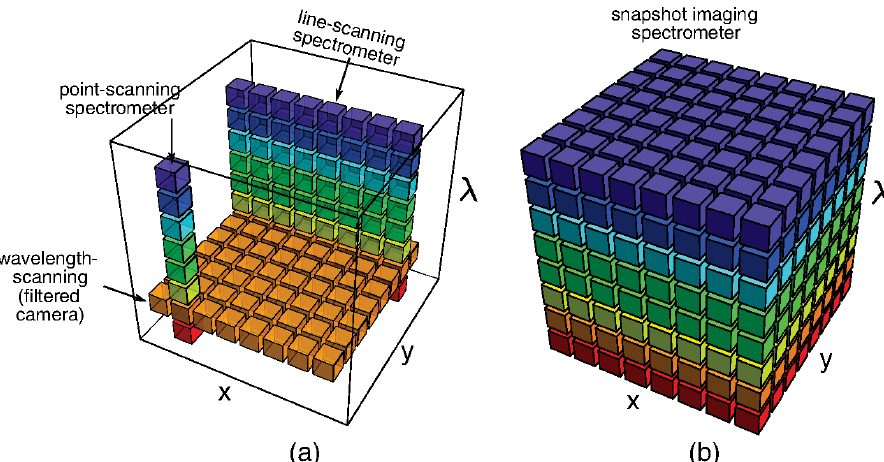
Figure 7. The portions of the datacube collected during a single detector integration period for ( a ) scanning and ( b ) snapshot devices. Reproduced from [43] under license CC BY 3.0.